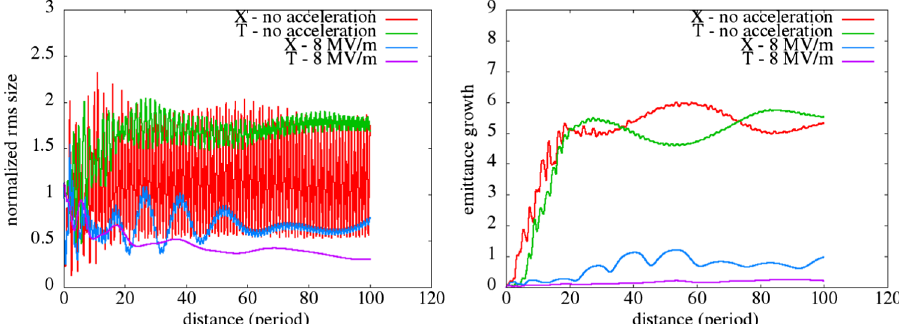
FIG. 10. The horizontal and longitudinal normalized rms size evolution (left) and emittance growth evolution (right) inside the quadrupole-rf channel without acceleration and with acceleration. The depressed transverse phase advance is 40 degrees with 120 degree zero current transverse and longitudinal phase advances.